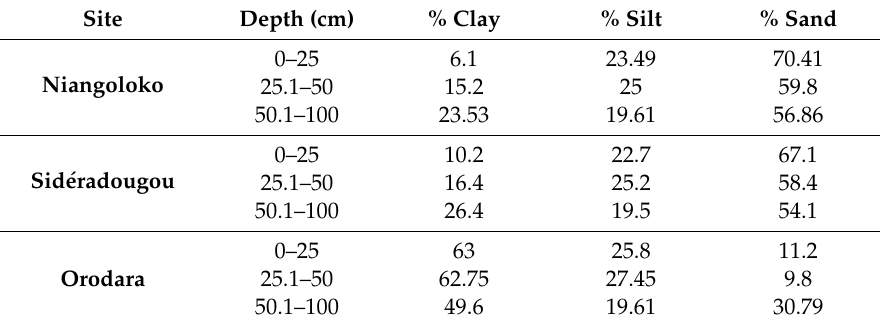
Table 2. Physical parameters of soil samples from the study